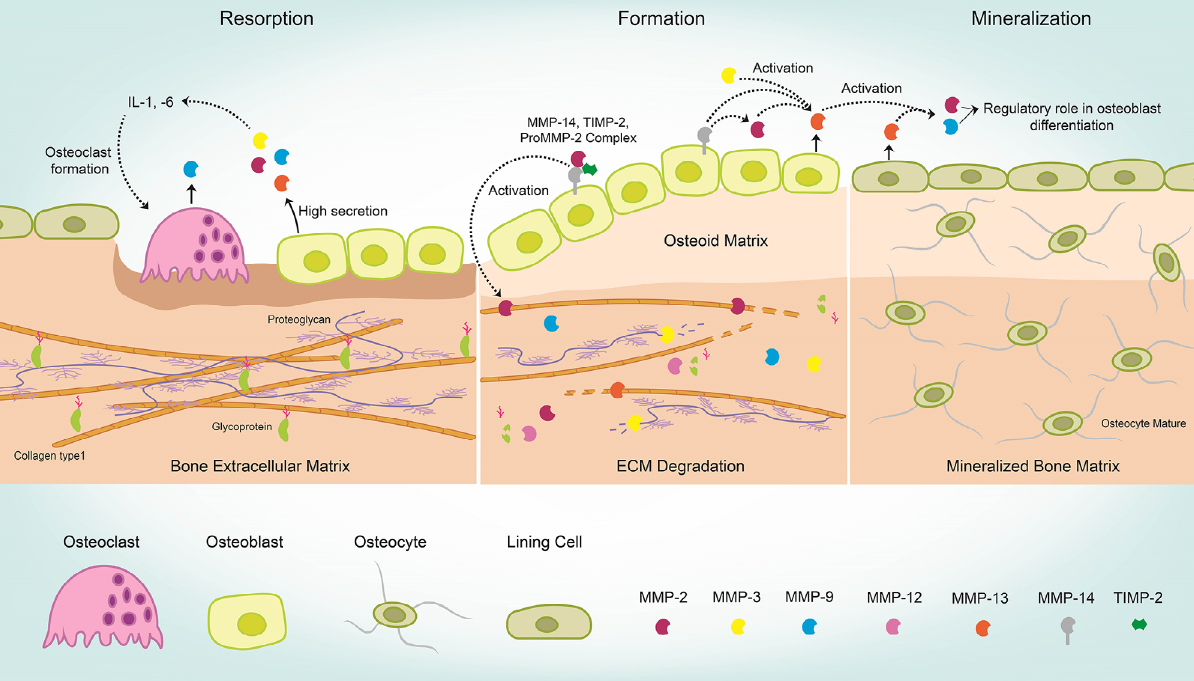
Figure 4- Osteoblast cells release MMPs (as -2, -3, -9 and -13), which have an important role in bone metabolism, activating osteoclast cells and consequently initiating matrix degradation. Afterwards, several matrix metalloproteinases work in coordination in order to form new ECM. Thus, a new mineralized matrix is formed through regulatory mechanism of cells and MMPs